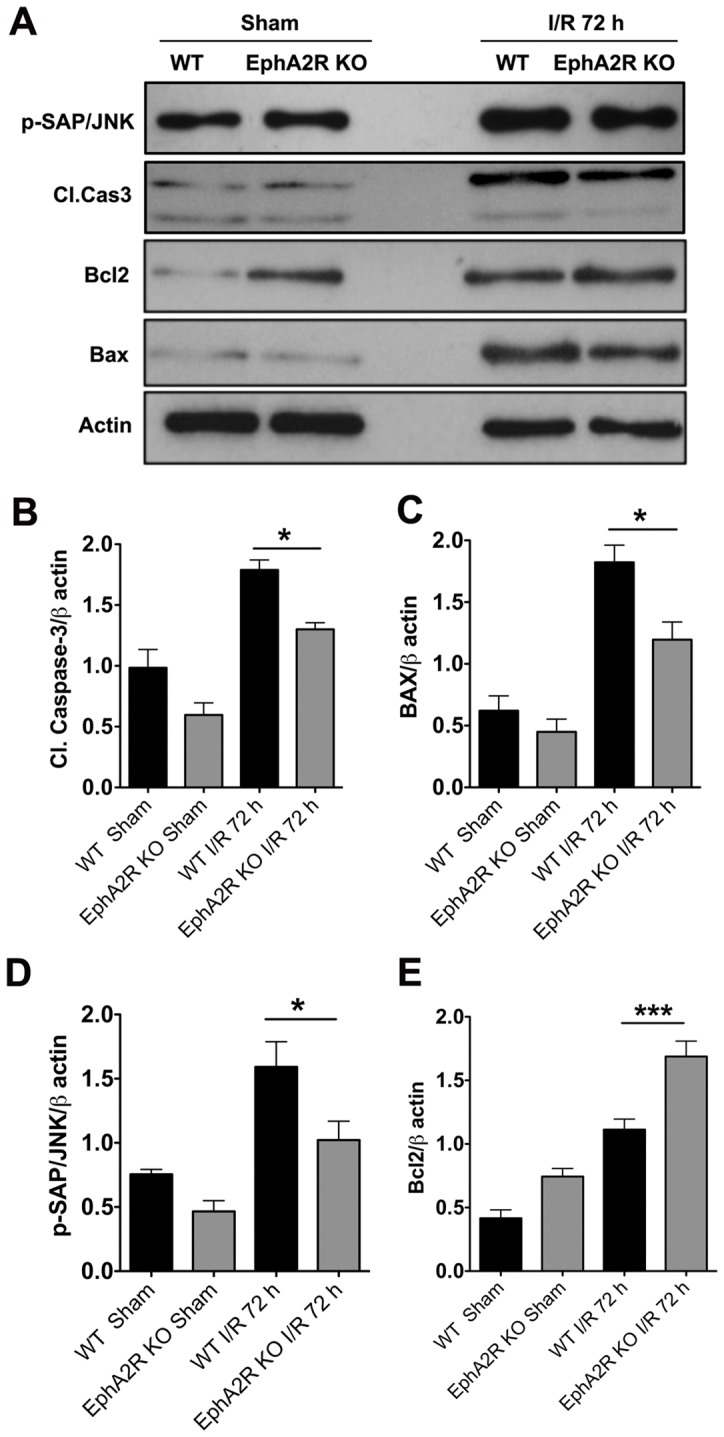
Apoptotic neuronal death is reduced in EphA2−/− mice following focal cerebral I/R.Ipsilateral cortical protein lysates from sham and I/R brains from both wild type and EphA2−/− mice were analyzed for selected pro- and anti-apoptotic proteins using immunoblotting. (A–D) EphA2−/− mice demonstrate significantly lower levels of apoptotic cell death (cleaved caspase-3; Cl. Cas3) and pro-apoptotic proteins (P-SAP/JNK, BAX) as compared to the wild type group following focal cerebral I/R. (A and E) EphA2−/− mice demonstrate significantly higher levels of the anti-apoptotic protein, Bcl–2, compared to wild type following cerebral I/R. Data are mean ± SEM, n = 4–5. *p<0.05, ***p<0.0001 relative to wild type.